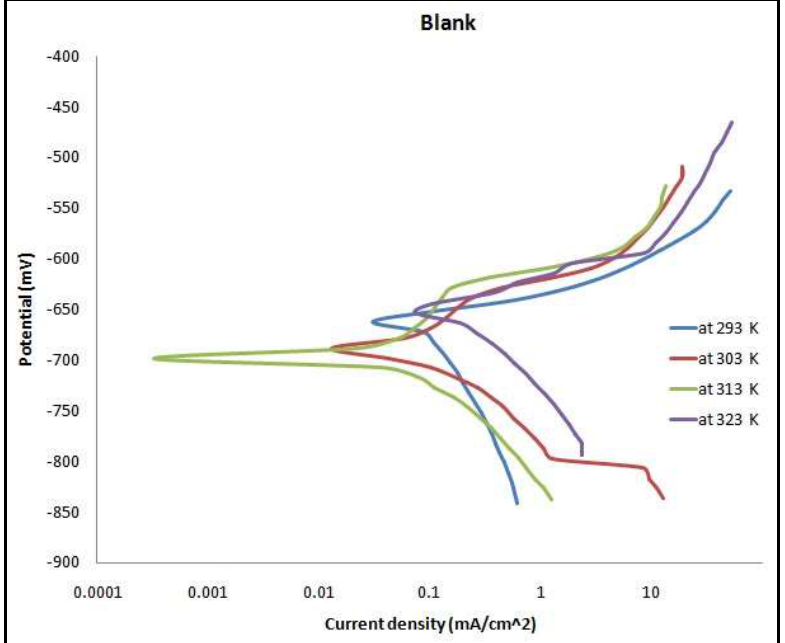
Figure 3: Tafel plot of aluminum in HCl at four temperatures.